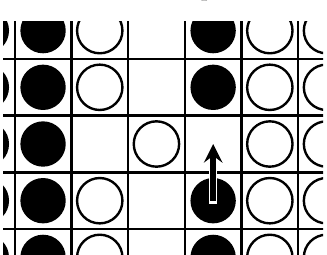
Figure 8. WHITE captures.